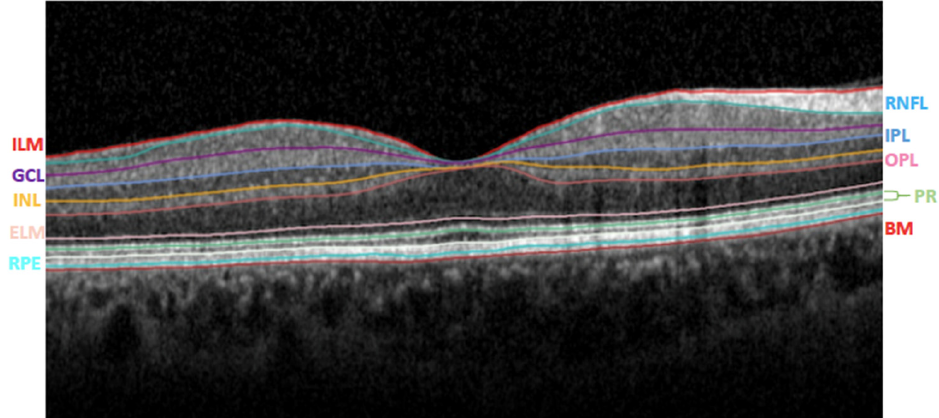
Figure 1. Segmentation of the retinal layers using the instrument’s automatic algorithm. ILM: internal limiting membrane; RNFL: retinal nerve fiber layer; GCL: ganglion cell layer; IPL: inner plexiform layer; INL: inner nuclear layer; OPL: outer plexiform layer; ELM: external limiting membrane; PR: photoreceptor layers; RPE: retinal pigment epithelium; BM: Bruch’s membrane. In addition, utilizing the standard Early Treatment Diabetic Retinopathy Study (ET- DRS) grid, the thickness of the retinal layers at the circle centered on the fovea (1 mm in diameter), the average of the 5 foveal and parafoveal zones (2 mm in diameter), and the average of the 9 foveal and parafoveal zones (3 mm in diameter) were evaluated (Figure 2).